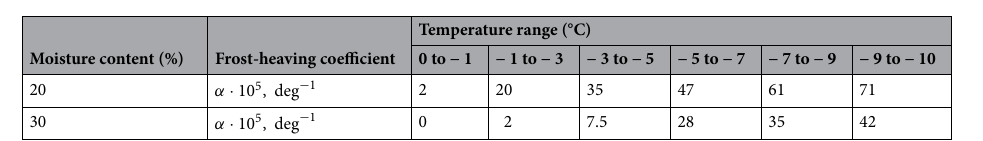
Table 3. Fitting the slope expansion coefficient with a one-dimensional expansion model.